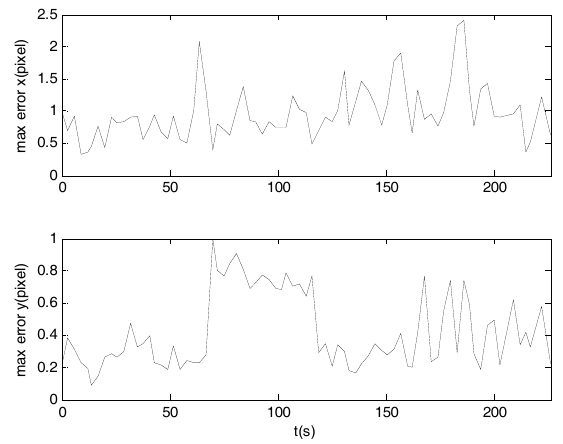
Sensors 2017 , 17 , 1921 Figure 16. Maximum star location prediction error of a night sky experiment. Figure 16. Maximum star location prediction error of a night sky experiment. Figure 16. Maximum star location prediction error of a night sky experiment.